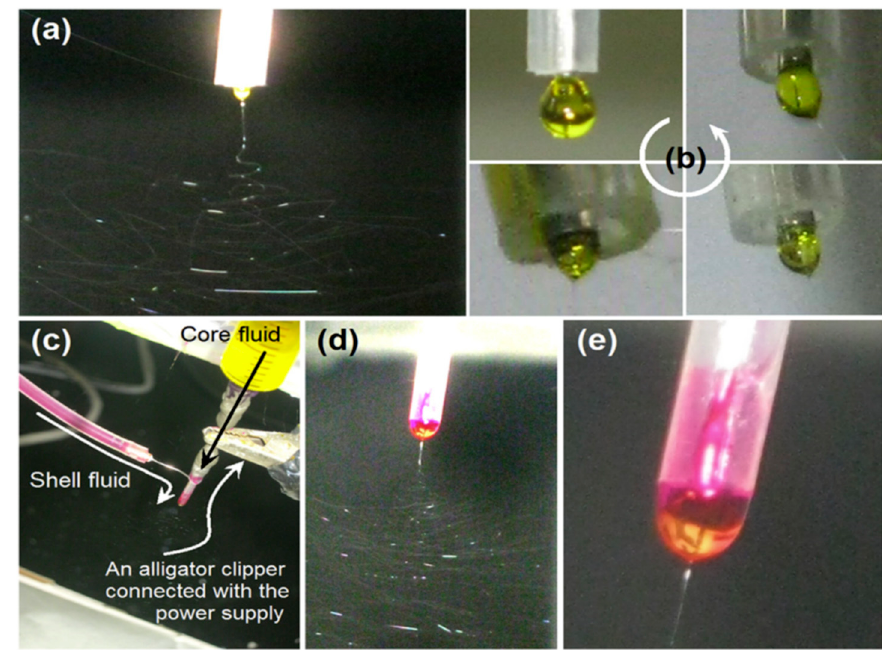
Figure 4. ( a ) Digital photographs showing a typical one-fluid electrospinning process, ( b ) formation of Taylor cone, ( c ) connection of spinneret in coaxial electrospinning, ( d ) enlarge image of the working region, and ( e ) Taylor cone with yellow core fluid encapsulate by rose-bengal shell solution [57] .